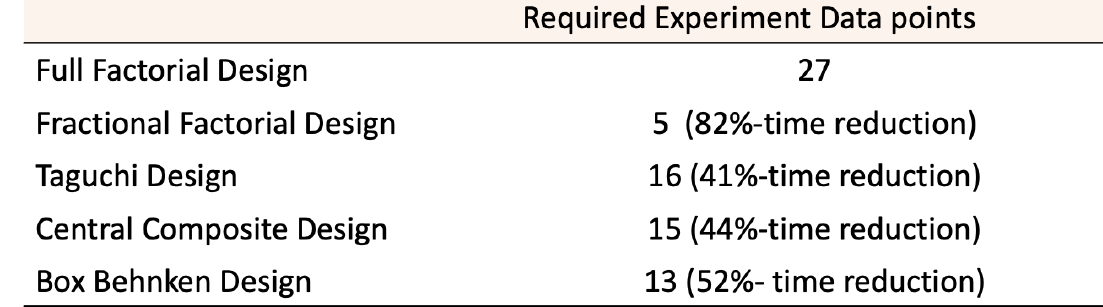
Table 1. Overview of the Design of Experiments (DoE) techniques.